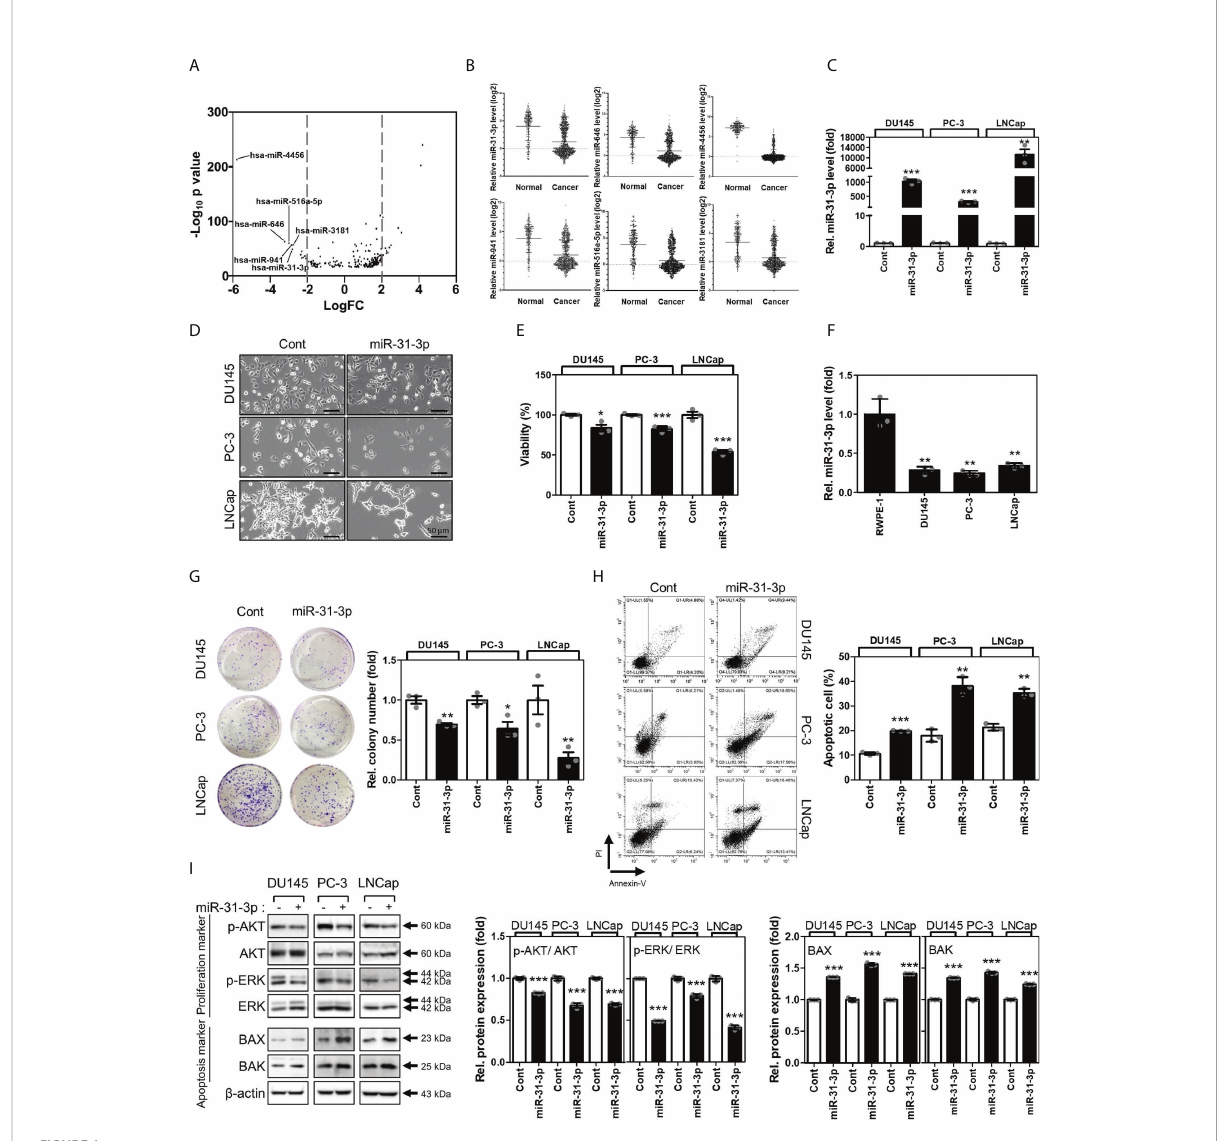
FIGURE 1 miR-31-3p induces prostate cancer cell apoptosis. (A) Volcano plots of the expressions of miRNAs for Gene Expression Omnibus data (GSE112264). The X-axis is the Log2 of miRNA expression (fold change) levels and the Y-axis adjusts the p value as a function of − Log10. (B) Relative expression levels of the 6 miRNAs in Gene Expression Omnibus data (GSE112264). (C) miR-31-3p expression after transfection with miR-31-3p. An unpaired two-tailed Student ’ s t -test was used to calculate P values. Error bars represent mean ± standard error of the mean (SEM). **P value < 0.01 and ***P value < 0.001 vs. Cont (n = 3). (D) Morphology of prostate cancer (PC) cells transfected with the control miRNA or miR-31-3p. (E) Growth-inhibiting effects of miR-31-3p. Unpaired two-tailed Student ’ s t -test was used to calculate the P value. Error bars represent mean ± SEM. *P value < 0.05 and ***P value < 0.001 vs. Cont (n = 3). (F) Comparison of miR-31-3p expression in normal and cancer cell lines. An unpaired two-tailed Student ’ s t -test was used to calculate P values. Error bars represent mean ± standard error of the mean